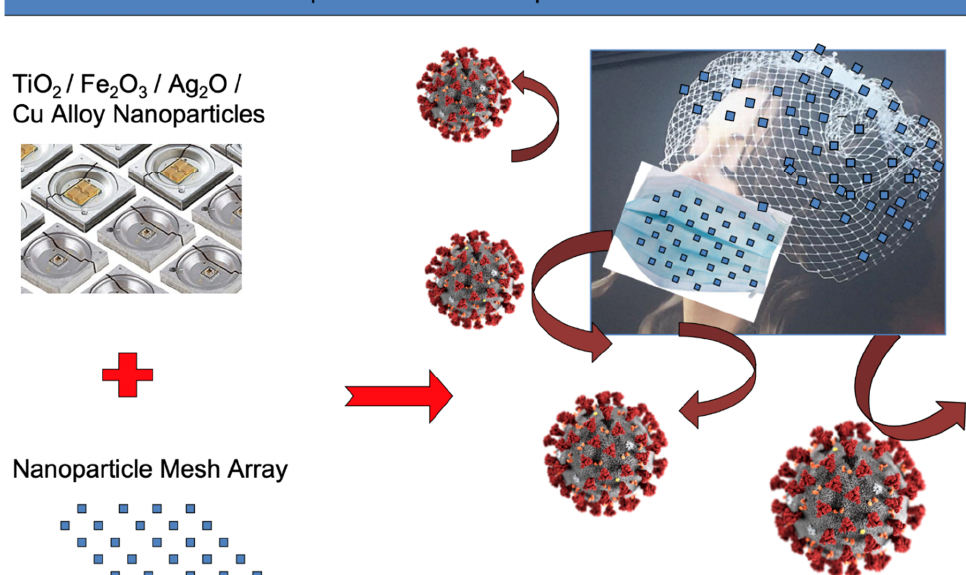
Figure 4. Electronic shield and repulsive field mask design with nanoparticles.